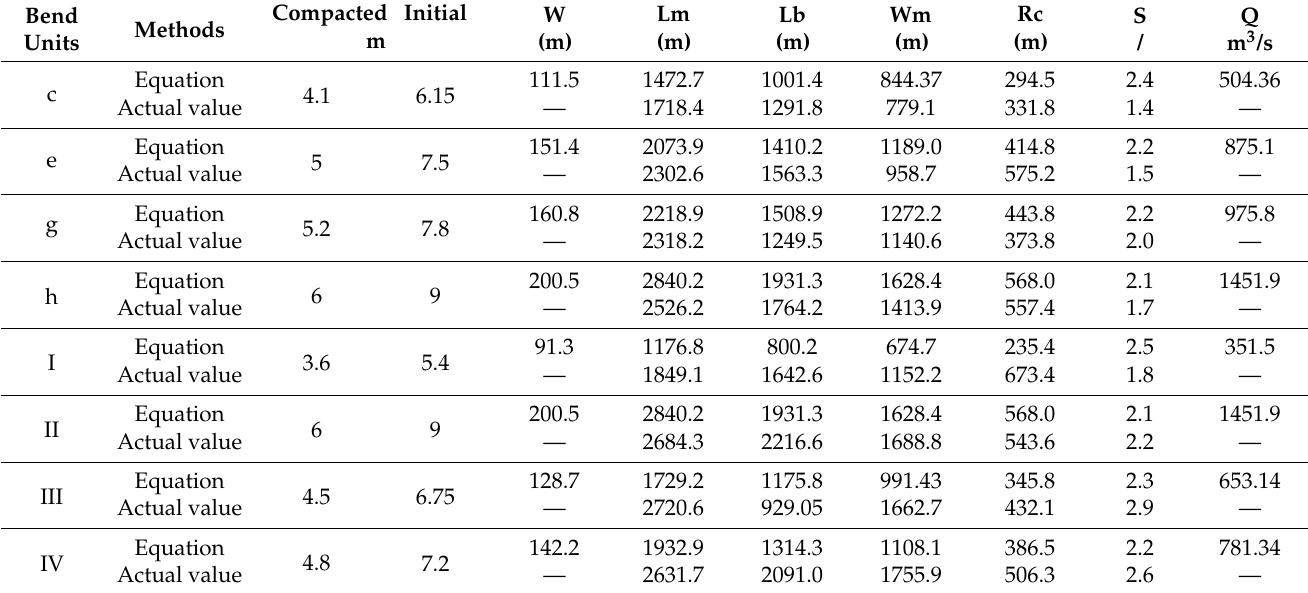
Table 2. Comparison of results from empirical equations and actual